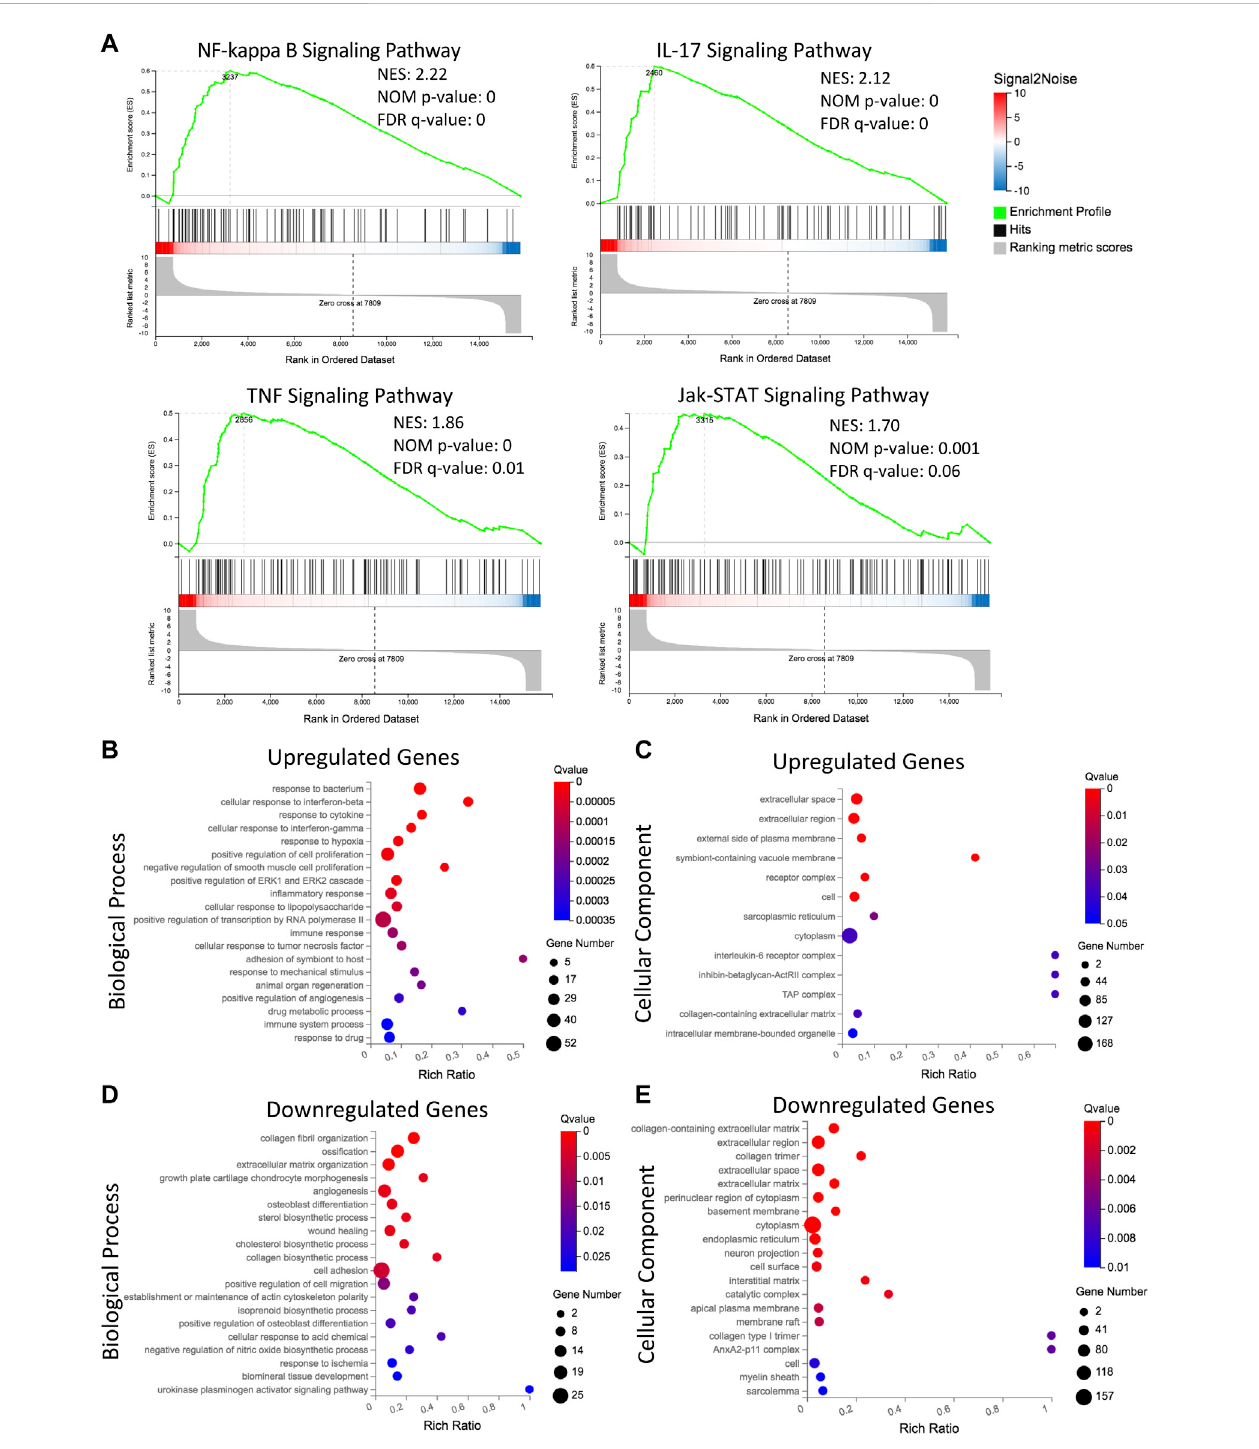
Transcriptomic analysis reveals distinct upregulation of immune and in fl ammatory related signaling, and downregulation of extracellular matrix and osteoblastogenesis related processes in L-MSCs. (A) Gene set enrichment analysis showing gene sets that are upregulated in L-MSCs (NF- κ B, IL-17, TNF and Jak-STATsignalingpathways).Normalizedenrichmentscore(NES),nominal(NOM) p -valueandfalsediscoveryrate(FDR)q-valueareshownforeachplot. (B) Gene ontology (GO) analysis of biological processes enriched in the 423 genes upregulated by L-MSCs. The top 20 signi fi cantly enriched biological processes are displayed (based on q-value ≤ 0.05). (C) GO analysis of cellular components enriched in the 423 upregulated genes in L-MSCs. The top 13 signi fi cantly enriched cellular components are displayed. (D) GO analysisof biological processes enrichedin the 347genes downregulated in L-MSCs. The top 20 signi fi cantly enriched biological processes are displayed. (E) GO analysis of cellular components enriched in the 347 downregulated genes in L-MSCs. The top 20 signi fi cantly enriched cellular components are